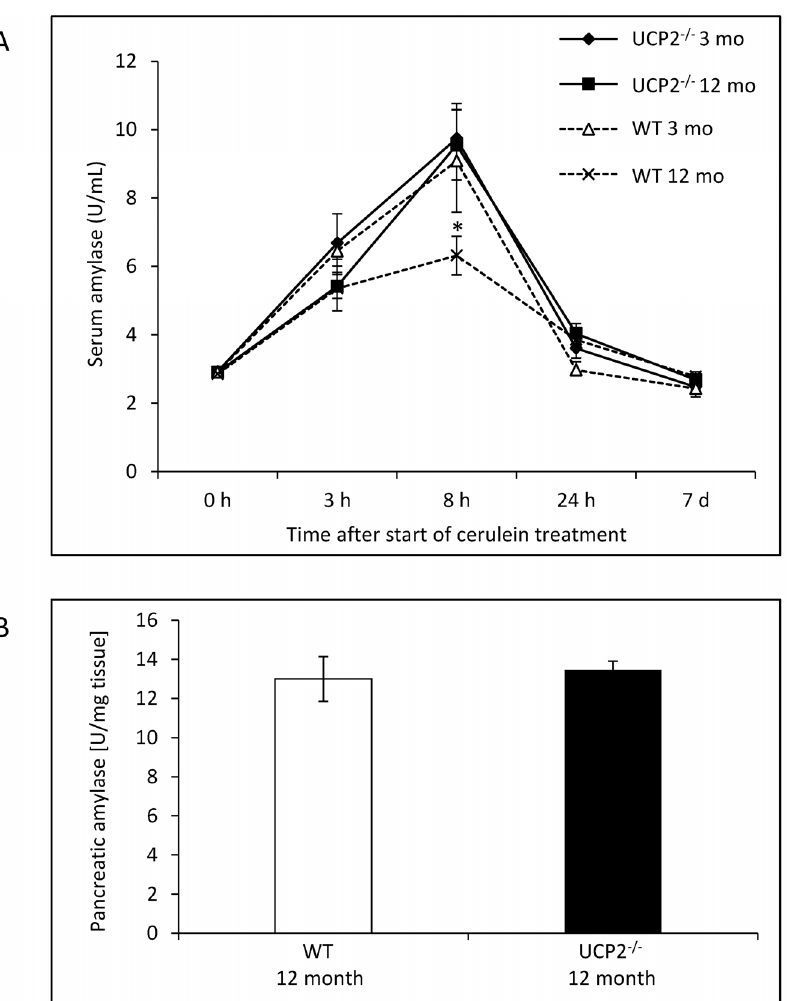
Figure 2. Measurements of a -amylase activities in WT and UCP2 -/- mice. (A) Mice of two age groups (3 and 12 months, respectively) were sacrificed at the indicated time points after the start of cerulein treatment (n=6–8 mice per experimental time point) and serum samples subjected to the analysis of a -amylase activities. Data are expressed as units per milliliter of serum (mean values 6 SEM). * P , 0.05 (12 months old WT versus UCP2 -/- mice). (B) Pancreatic tissue of untreated WT and UCP2 -/- mice at an age of 12 months (n=6 per group) was subjected to the detection of a - amylase activities. Data are expressed as U/mg wet weight (mean 6 SEM).